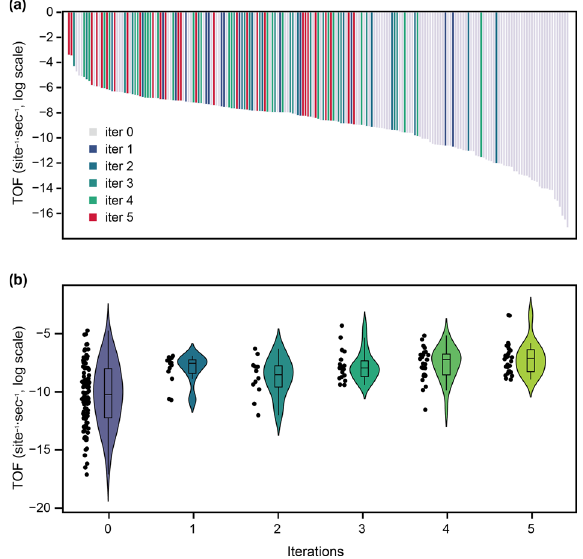
Figure 3. ( a ) TOF of NH 3 formation on 224 Rh−Ru alloy surfaces. The TOF values from different DFT-GAN iterations (iter = 1–5) are coded in different colors. The iter = 0 corresponds to the original dataset. The dataset is sorted according to the DFT value, i.e., from the highest (left) to the lowest (right). The reaction temperature and total pressure were set to 700 K and 100 bar, respectively. ( b ) Box and violin plots of the TOF values for iter = 0–5. The line inside the box represents the median value. The points on the left of the violin represent the raw TOF value at each